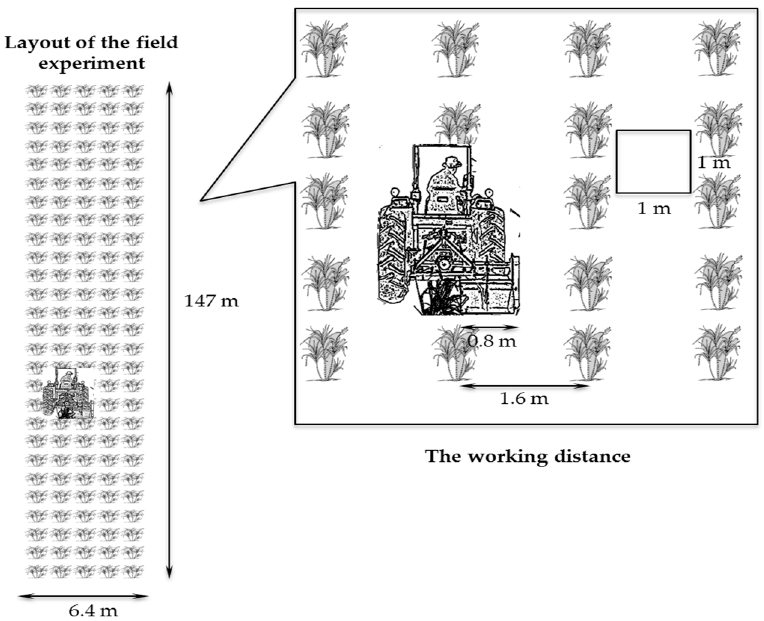
Figure 5. The layout of the field experiment and the working distance.